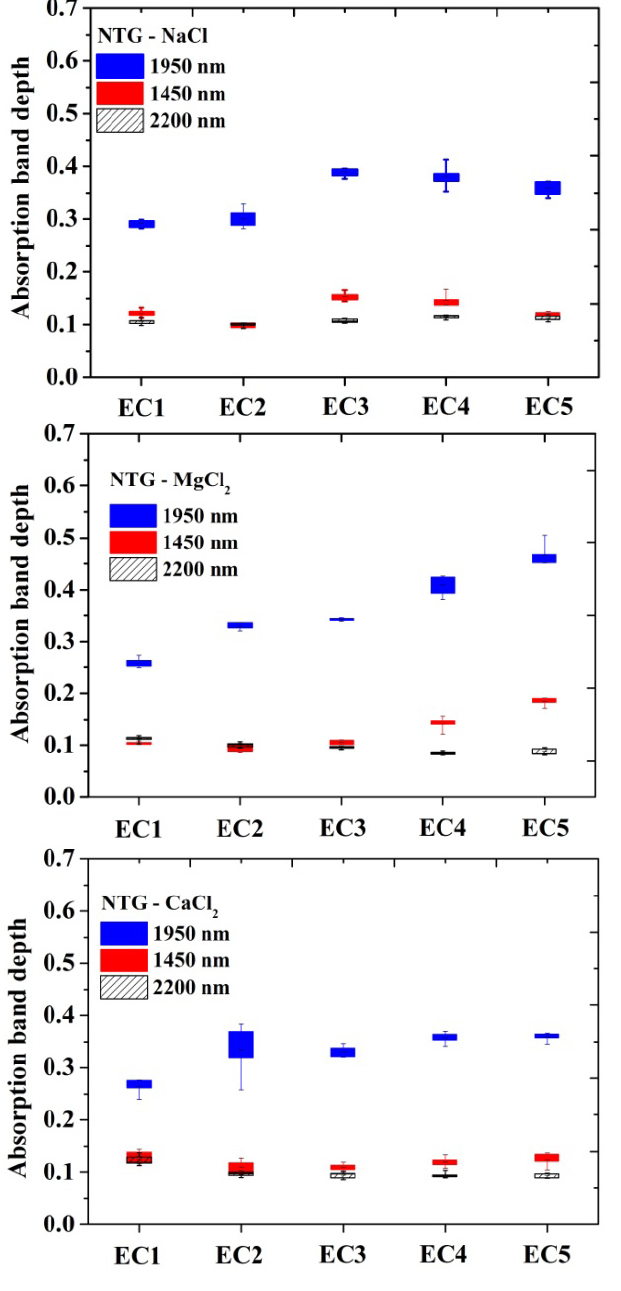
Figure 11. Changes in average depth and standard deviation of the major absorption bands present in the reflectance spectra of the NTG ( left ) and TG ( right ) samples of fluvent soil for different salts (NaCl, MgCl and CaCl ) and electrical conductivity (EC) 2 2